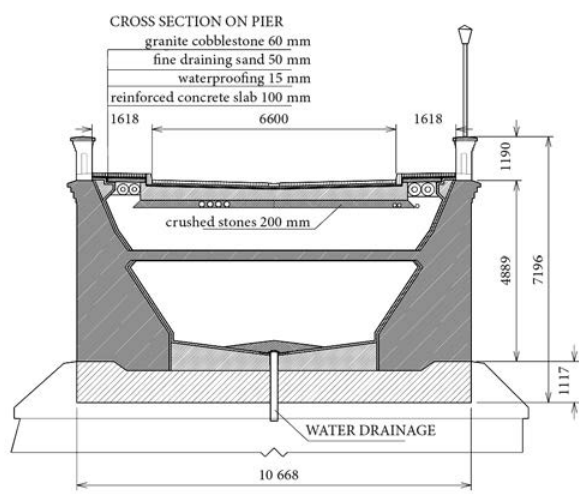
Fig. 13. View of the carriageway after reconstruction